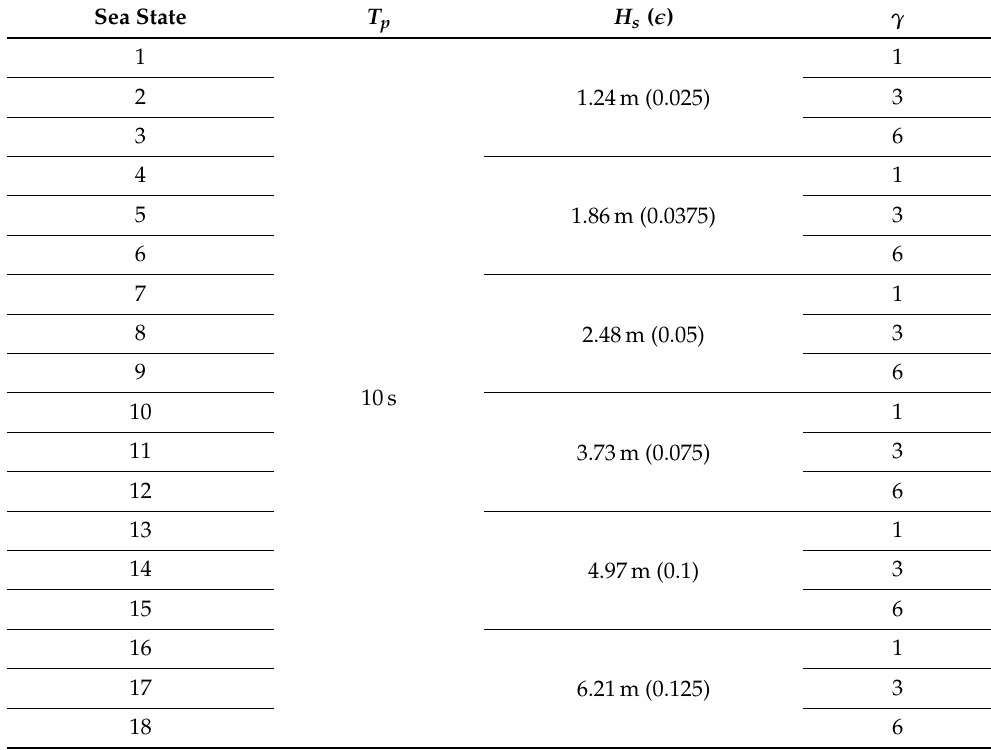
Table 1. Overview of the numerically investigated characteristic sea state